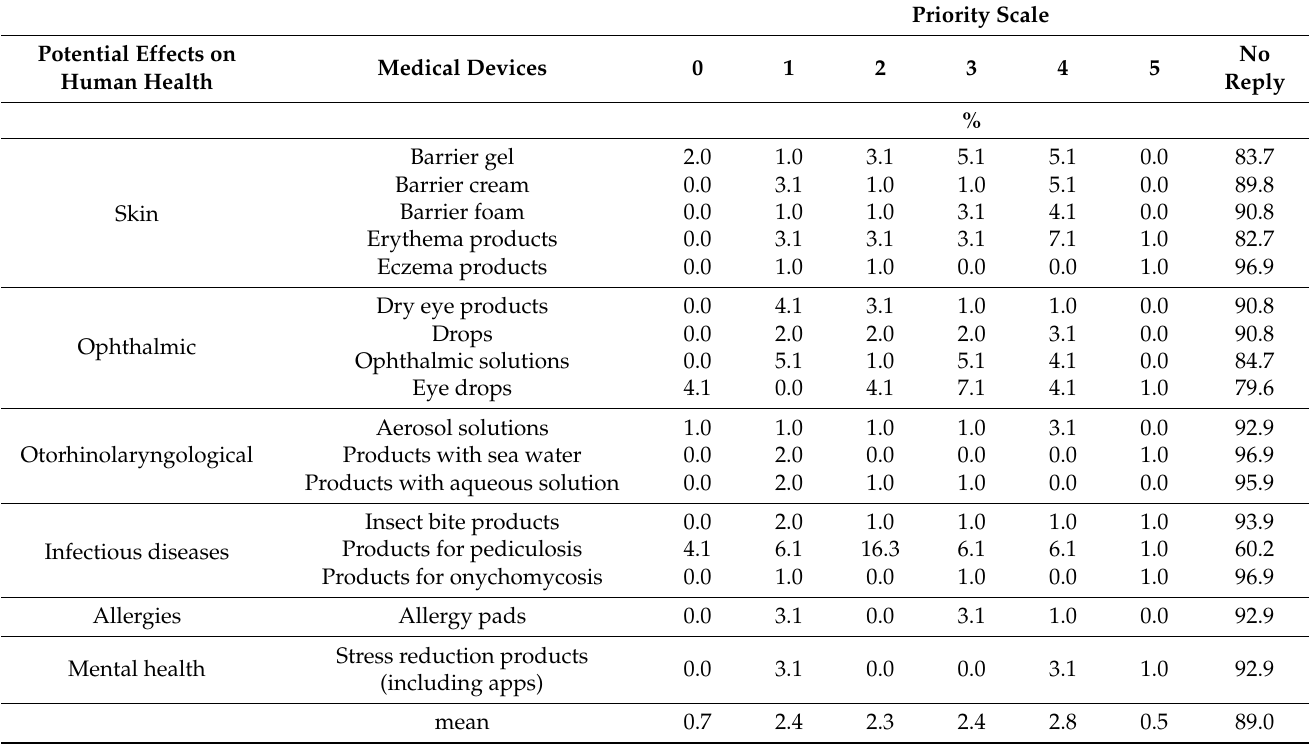
Table 4. Percentages of answers given by veterinarians about which medical devices can mitigate the effects of GEC on human health.